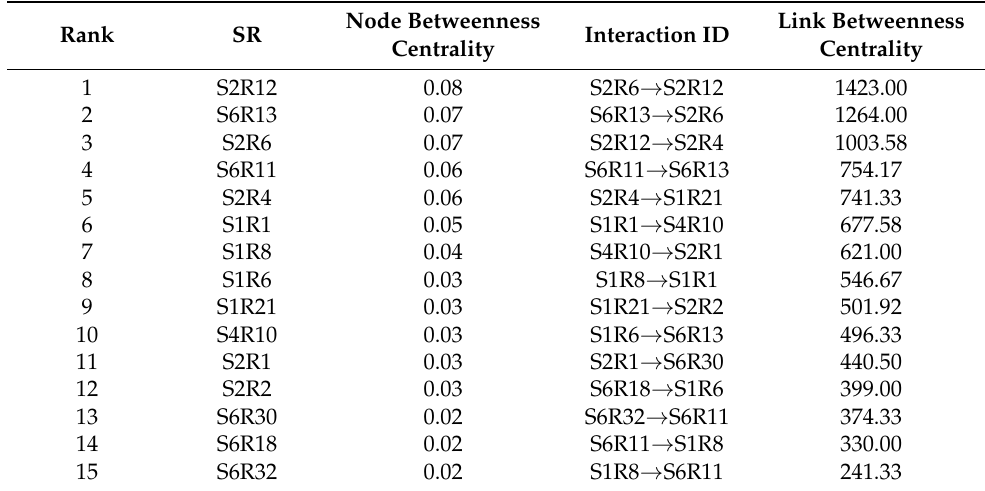
Table 3. Critical risk factors and relationships based on node/link centrality. Rank